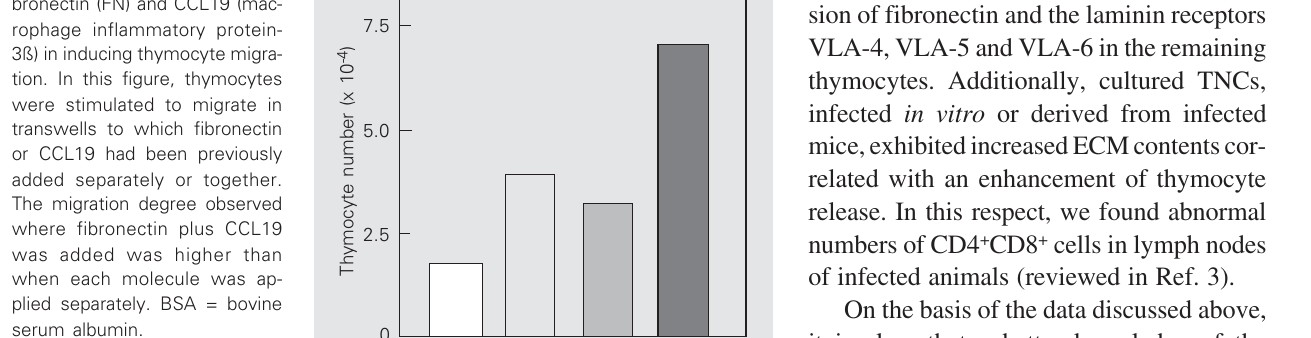
tion. In this figure,